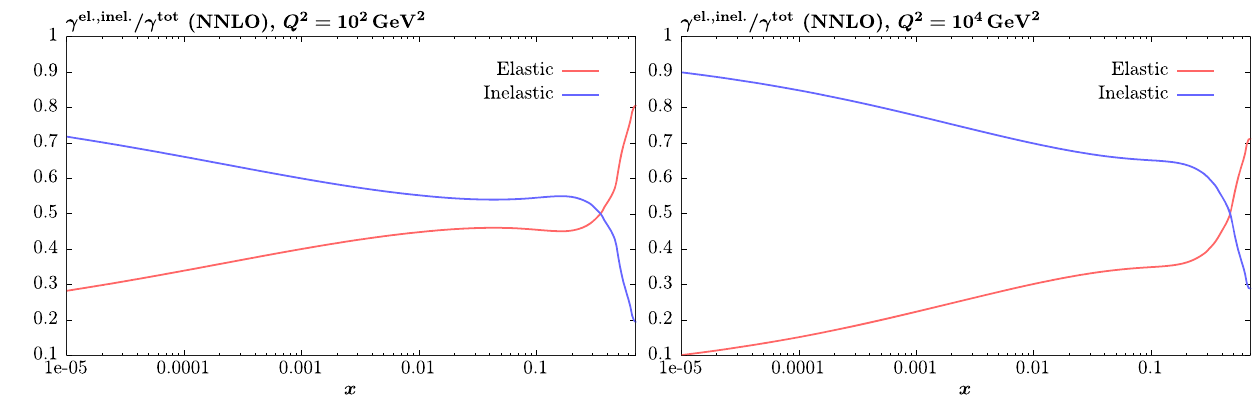
Fig. 8 Ratio of the inelastic and elastic components to the total (given by the sum of both) photon. Results at Q 2 = 10 2 ( 10 4 ) GeV 2 are shown in the left (right) plots